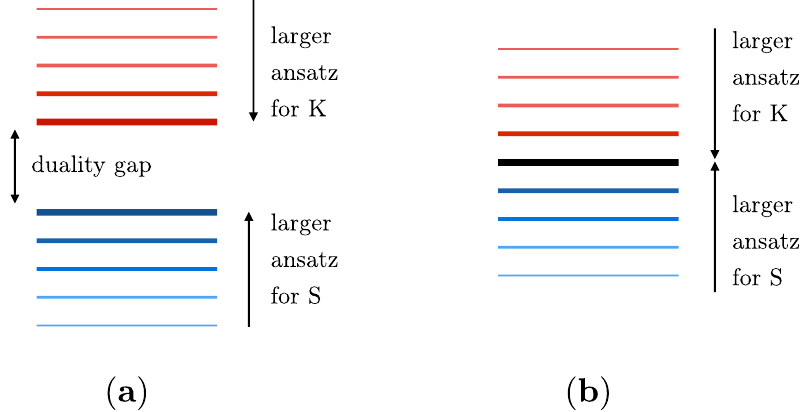
Figure 3 . By construction, the minimum of the dual problem (1.4) puts a strict upper bound on the maximum of the original problem (1.2). A priori the optimal minimum and the optimal maximum are separated by what is known as the duality gap as depicted in ( a ). For convex problems the duality gap is zero and thus both problems describe the very same boundary of the S-matrix space, one converging from its interior, the other from its exterior, see ( b ). With di(cid:11)erent ansatze we can thus rigorously bracket the optimal bound (in black in ( b )). Strictly speaking the previous